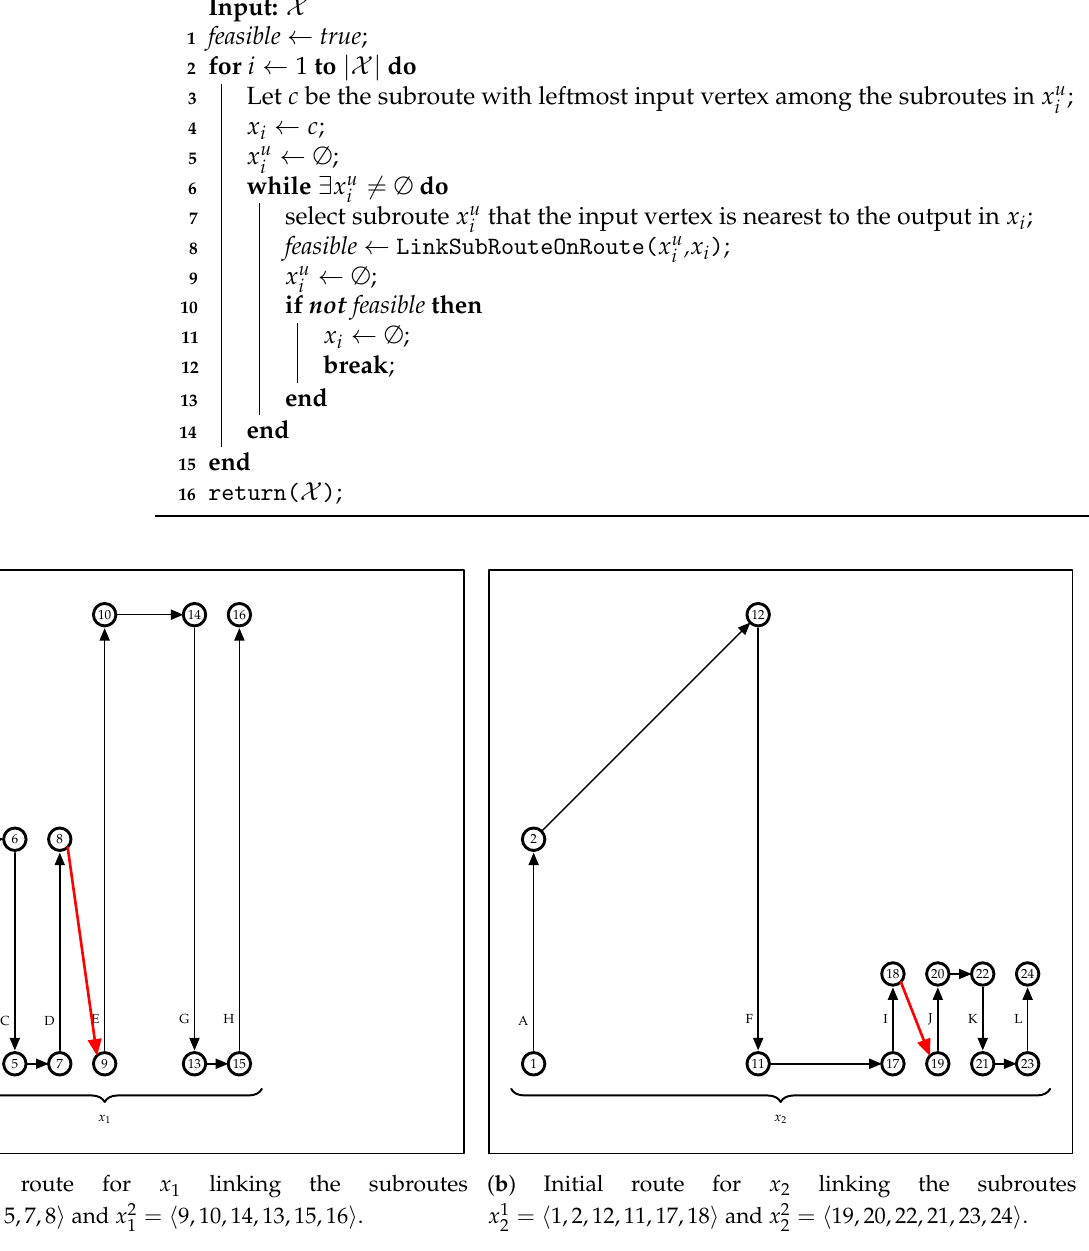
Figure 5. Example of subroutes linked to build the route x 1 and x 2